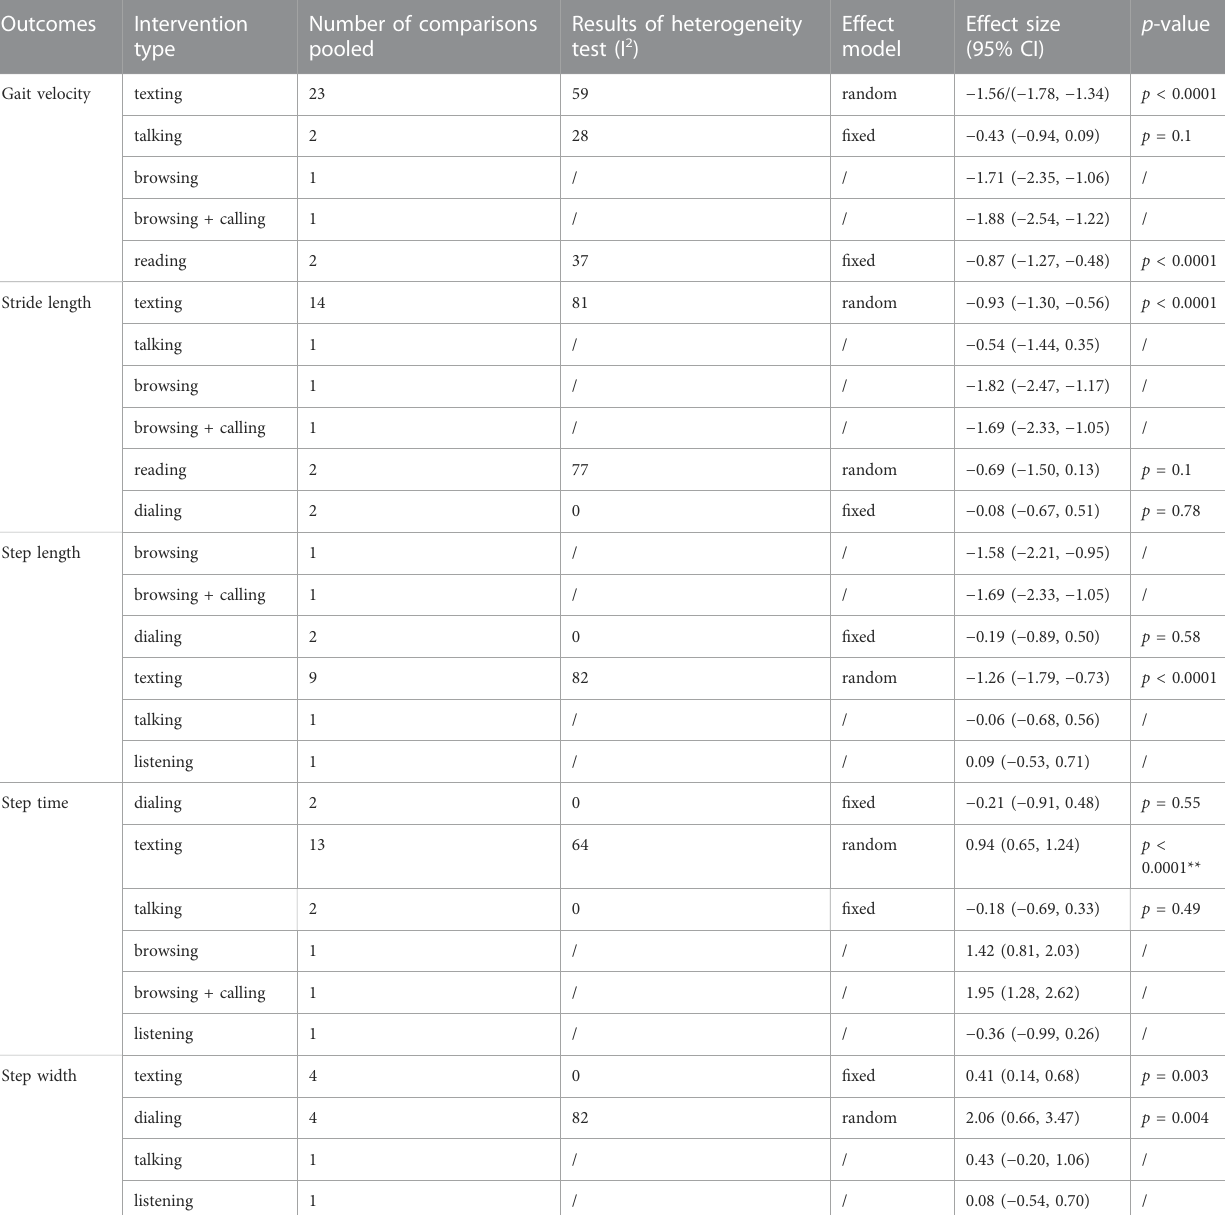
TABLE 3 Subgroup analysis of the effect of different mobile phone use tasks on gait